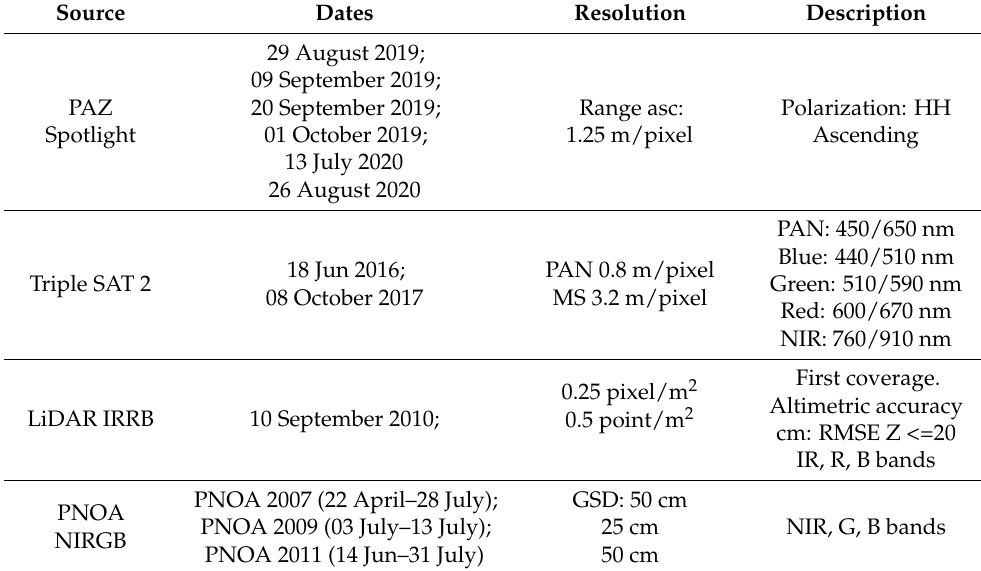
Table 1. Technical information on the data sources